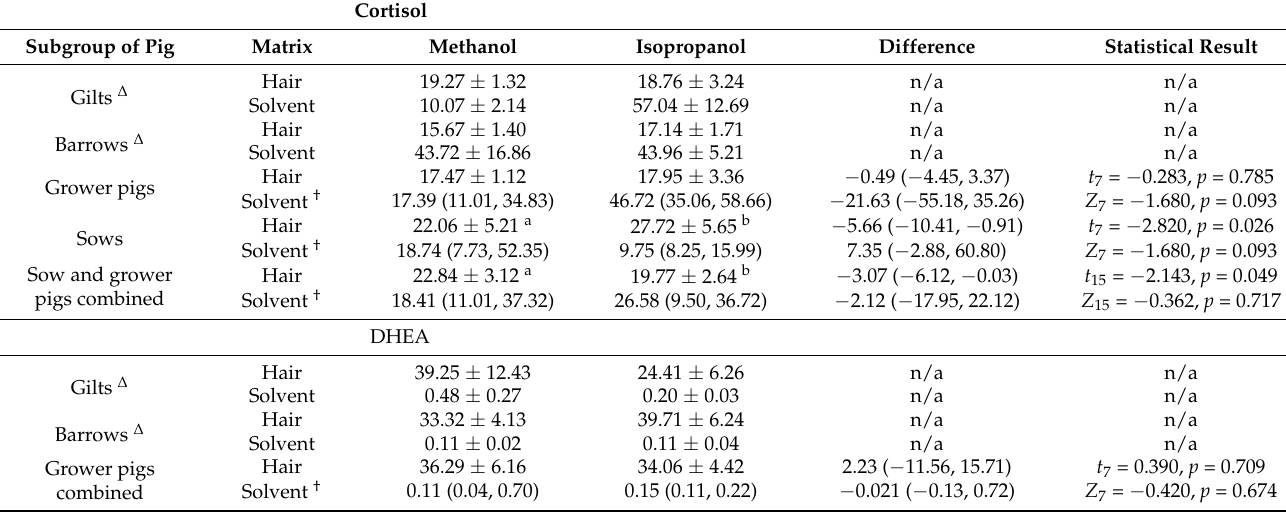
Table 1. Concentrations of cortisol and DHEA (pg/mg) and difference in the hair and wash solvents in pigs separated by gender and animal age. Data expressed as the mean ± SEM or median and first and third quartiles, depending on normality of